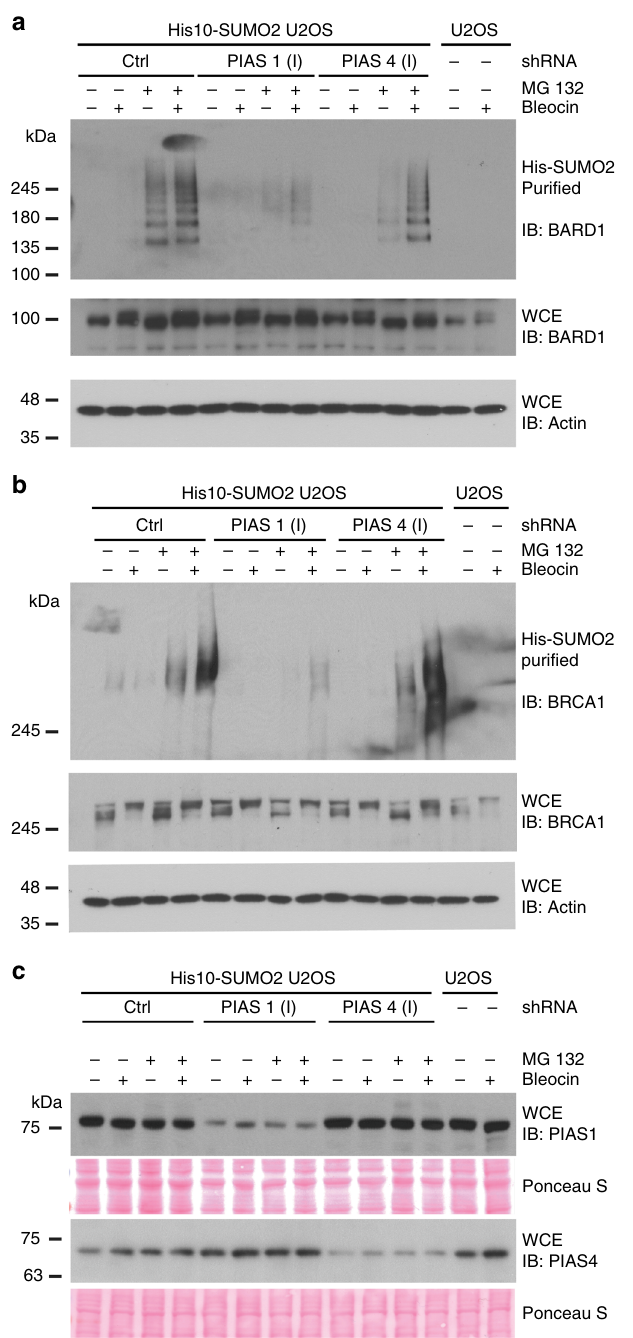
Fig. 6 The SUMO E3 ligase PIAS1 is responsible for the SUMOylation of BARD1 and BRCA1. a – c U2OS cells stably expressing His10-SUMO2 were infected with lentiviruses expressing shRNAs directed against PIAS1 or PIAS4 or a control shRNA. Three days after infection, the cells were either mock-treated or treated with MG132 (10 µ M) to inhibit the proteasome. One hour after the start of MG132 treatment, the cells were either DMSO- treated or treated with Bleocin (5 µ g/ml). DNA-damaged and undamaged cells were subsequently incubated for 4 h, lysed in a denaturing buffer and His10-SUMO2 conjugates were puri fi ed. a Levels of SUMOylated BARD1 and total BARD1 were determined by immunoblotting. b Levels of SUMOylated BRCA1 and total BRCA1 were determined by immunoblotting. c Knockdown ef fi ciencies of PIAS1 and PIAS4 were determined by immunoblotting. The experiment was independently repeated using other shRNAs directed against PIAS1 and PIAS4. Additionally, the SUMO2 puri fi cation ef fi ciency was determined by immunoblotting. These results are provided in Supplementary Fig. 6. Unprocessed full-size scans of blots are provided in Supplementary Fig. 9. The experiments were repeated three times. Unprocessed full-size scans of blots are provided in Supplementary Fig.